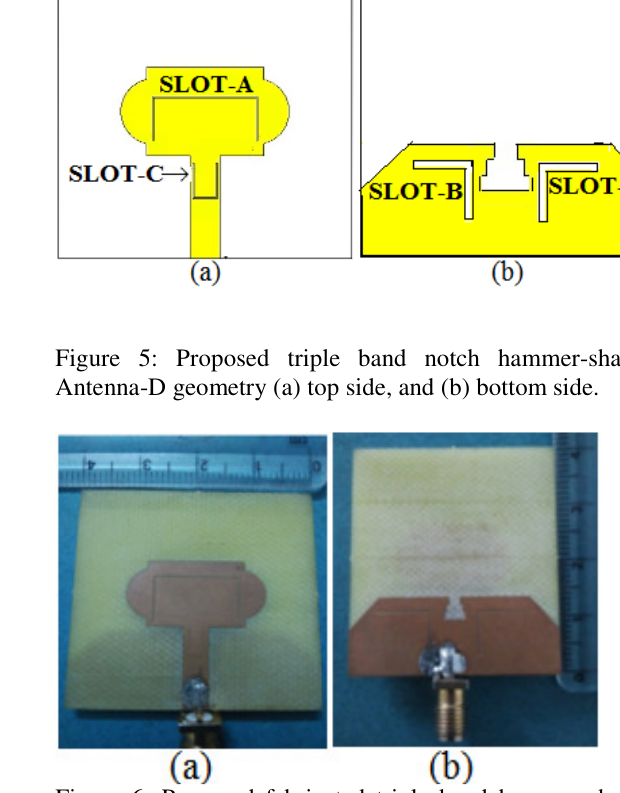
Figure 6: Proposed fabricated triple band hammer-shaped Antenna-D (a) top side, and (b) bottom